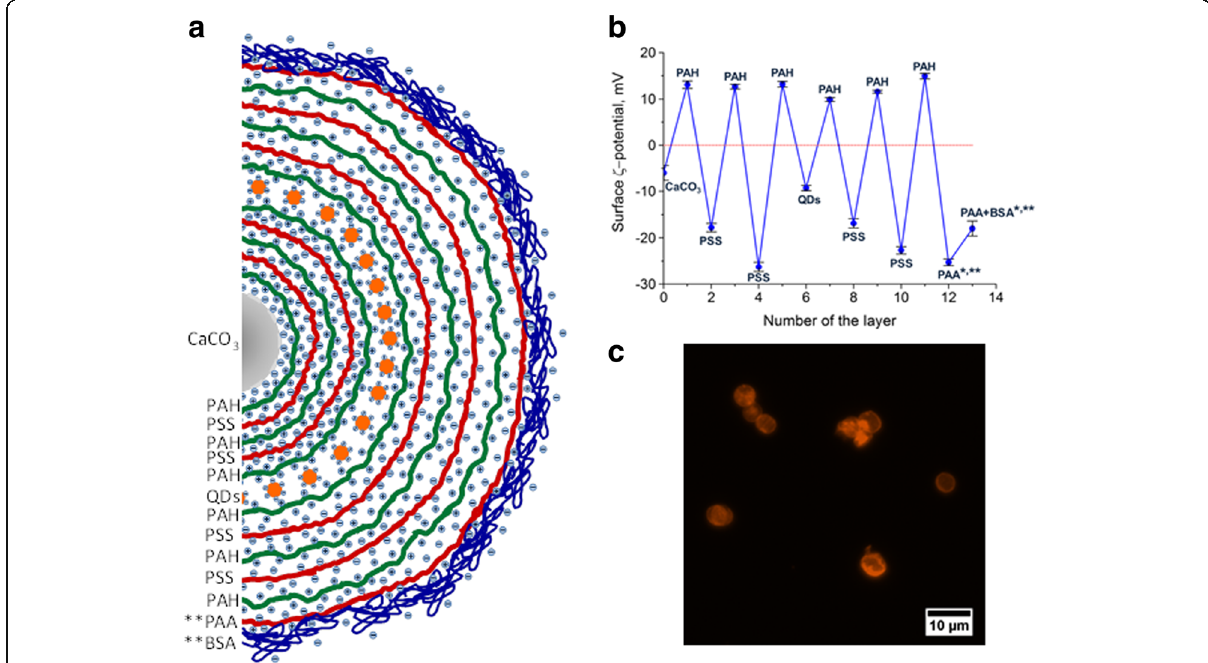
Fig. 1 The design and structure of the polyelectrolyte microcapsules encoded with quantum dots (QDs): a A schematic diagram of the arrangement of the layers in the polymer microcapsule membrane. b Changes in the ζ -potential of the surface of the calcium carbonate microparticles during layering of polymeric electrolytes and QD encoding. c A fluorescent microphotograph of the polyelectrolyte microcapsules encoded with CdSe/ZnS QDs solubilized with HS-PEG 12 -COOH. * The ζ -potentials of the microcapsule surface after the core was removed; ** an additional stage in the fabrication of QD-encoded polyelectrolyte microcapsules with a BSA-modified